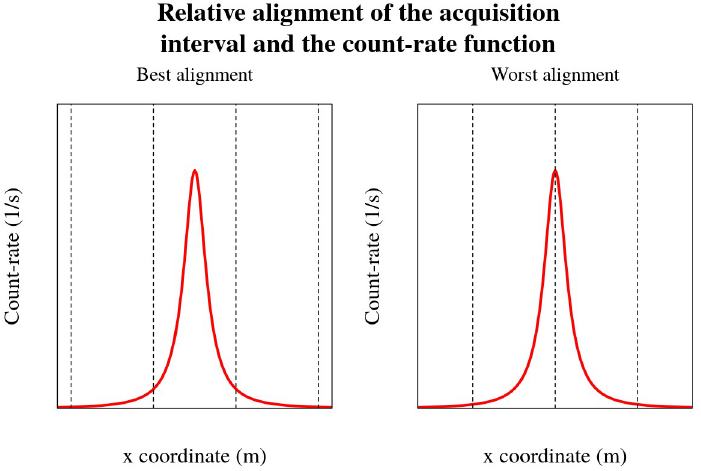
Fig 5. Visualisation of relative alignment of the count-rate function and the acquisition time intervals. On the left a best alignment situation is displayed, when the the detector was the closest to the source during the acquisition interval. On the right, worst alignment situation is displayed, when the closest distances to the source are divided between two adjacent acquisition time